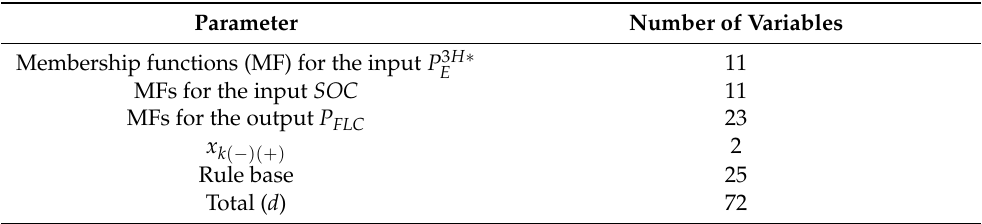
Table 2. Number of variables for each fuzzy logic control (FLC) parameter. Parameter Number of